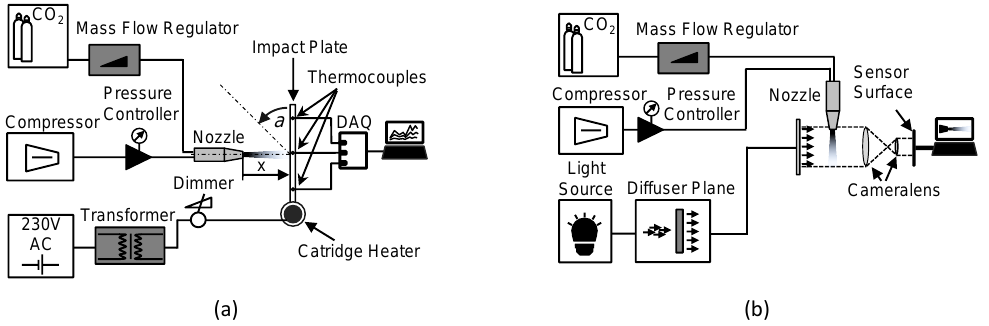
Figure 1. ( a ) Schematic test bench structure to evaluate the cooling effect. ( b ) Schematic test bench structure to characterize the open jet with regards to the jet intensity and jet fluctuations.